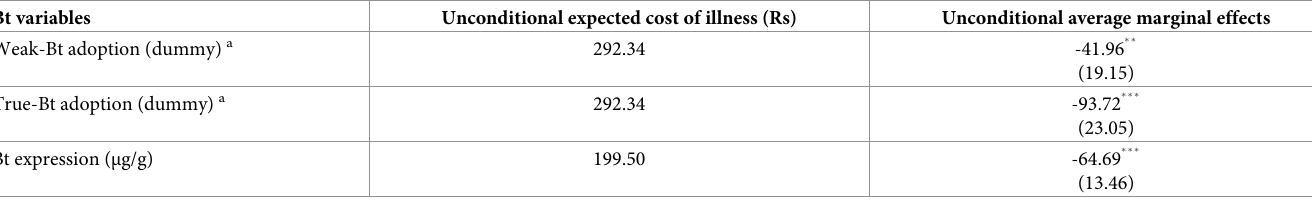
Table 7. Unconditional marginal effects of Bt adoption on farmers’ health